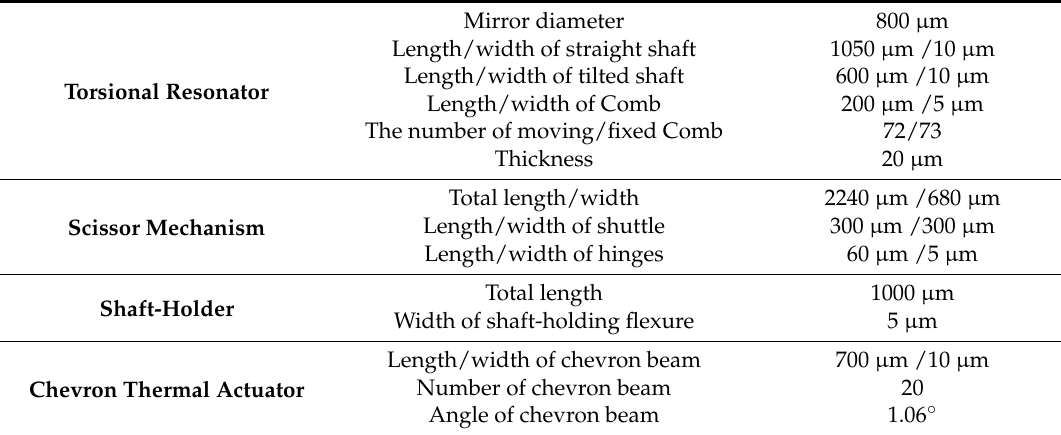
Figure 6. The cross-sectional view of the torsional shaft and shaft-holding flexure, showing two different restriction modes between the torsion bar and shaft-holding flexure. ( a ) No separation mode: the shaft-holding flexure is torsionally deformed together with the torsional shaft. The areal contact is maintained; ( b ) Separation mode: the areal contact is not maintained and the separation between the torsional shaft and shaft-holding flexure exist. Table 1. Design parameters for the torsional resonator and tuning unit.